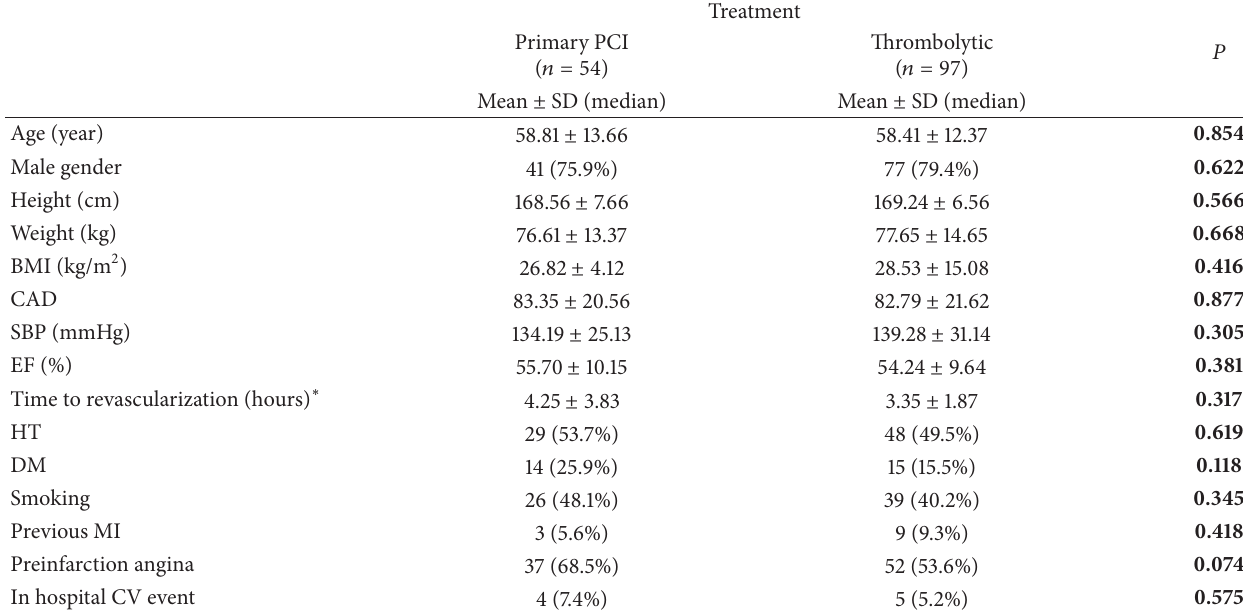
Table 1: Demographic and clinical characteristics of patients.